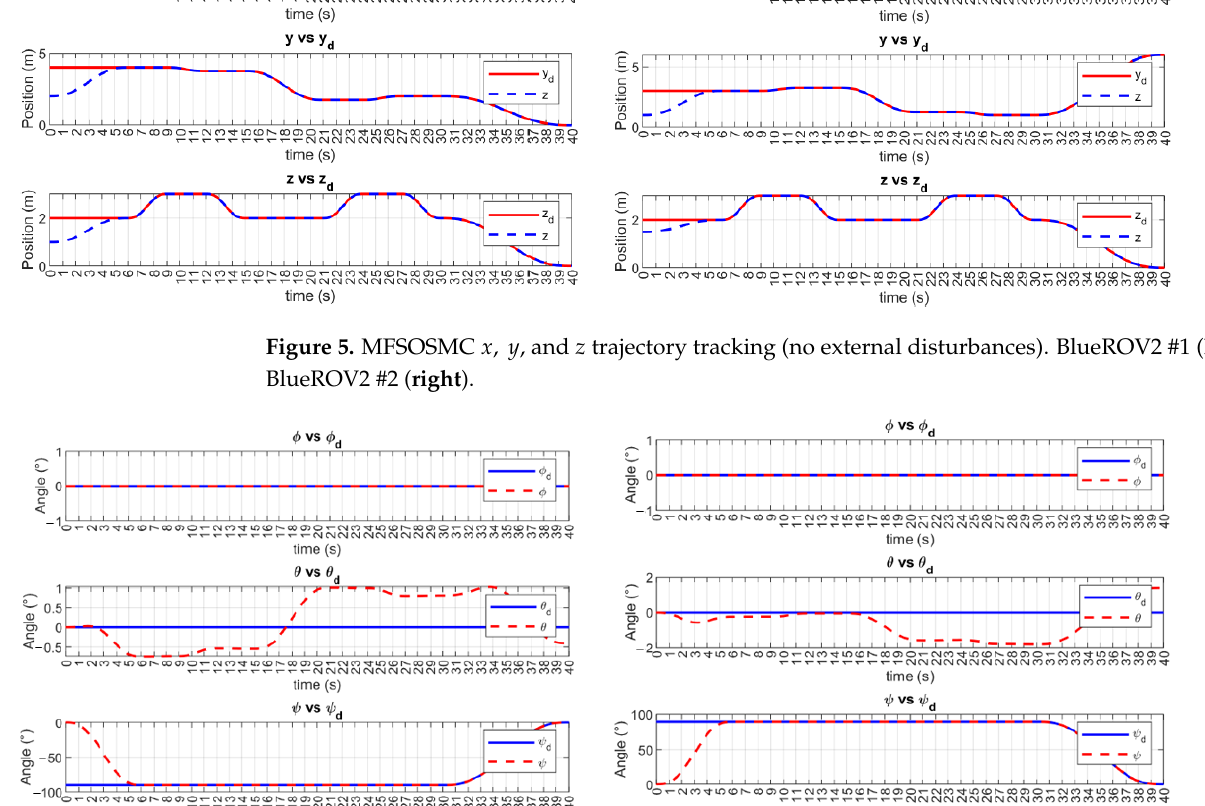
Figure 6. MFSOSMC 𝜙, 𝜃, and 𝜓 trajectory tracking (no external disturbances). Left : BlueROV2 #1. Figure 6. MFSOSMC φ , θ , and ψ trajectory tracking (no external disturbances). Left : BlueROV2 #1.